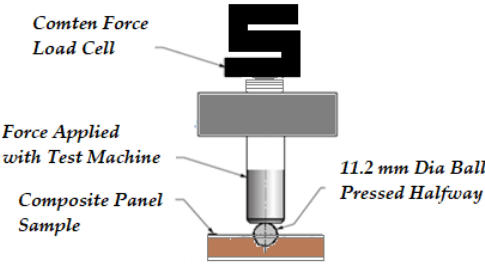
Figure 3. Janka hardness measurement with Comten 95 Series Universal Testing machine.